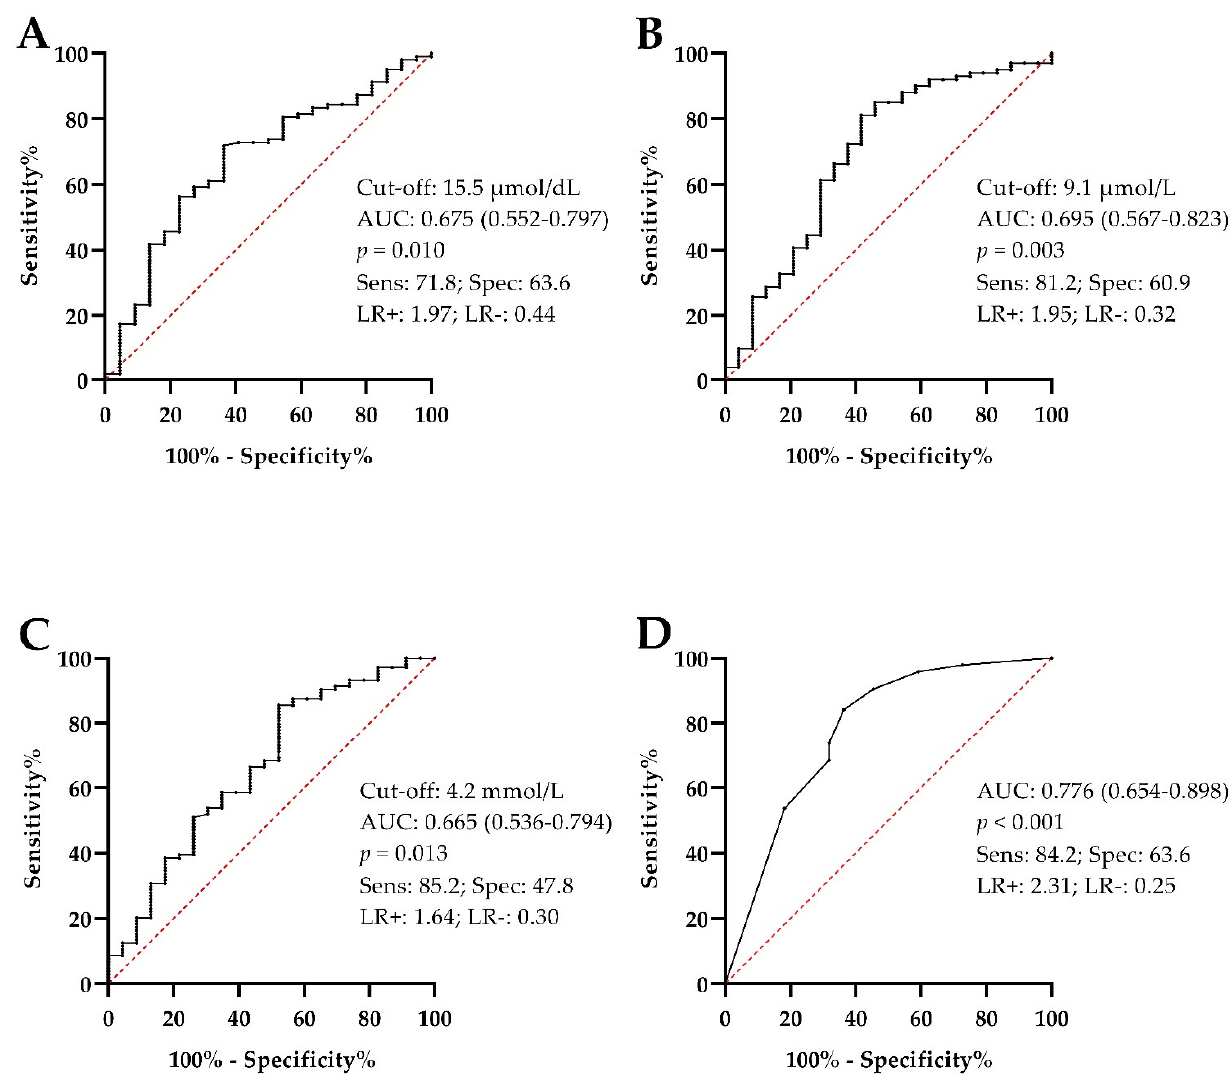
Figure 2. Receiver operating characteristic curves of triglycerides ( A ), uric acid ( B ), calcium ( C ) and the combination of these three biomarkers ( D ) for discriminating EGUS from animals with other diseases with similar clinical symptoms of EGUS but with a negative endoscopy result. AUC, area under the curve; CI, confidence interval; Sens, sensitivity; Spec, specificity; LR, likelihood ratio.